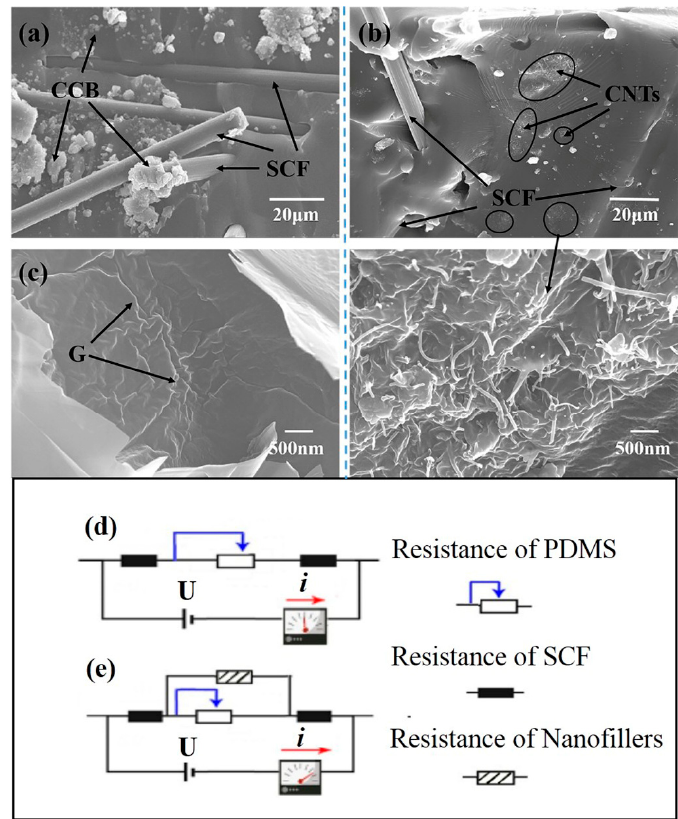
Figure 5. SEM images of PDMS/SCF (4 wt %) composites containing 1 wt % of a second nanofiller: ( a ) CCB; ( b ) CNTs; and ( c ) graphene; resistance of conductive network in the polymer matrix ( d ) PDMS/SCF and ( e ) PDMS/SCF containing a second filler.